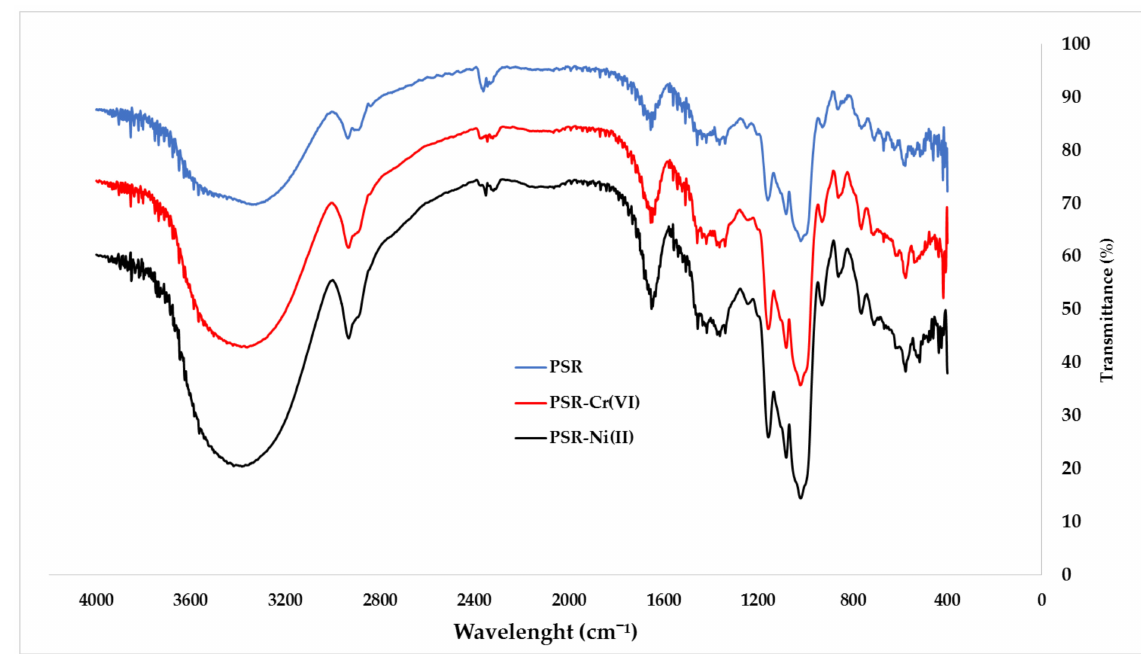
Figure 1. IR spectrum of PSR before and after Cr (VI) and Ni (II) removal.